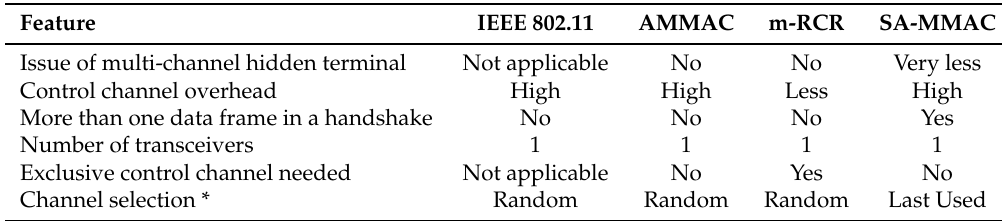
Table 1. Comparison of features of IEEE 802.11, asynchronous multi-channel MAC (AMMAC), and SA-MMAC. m-RCR: reliable channel-based multi-channel MAC.